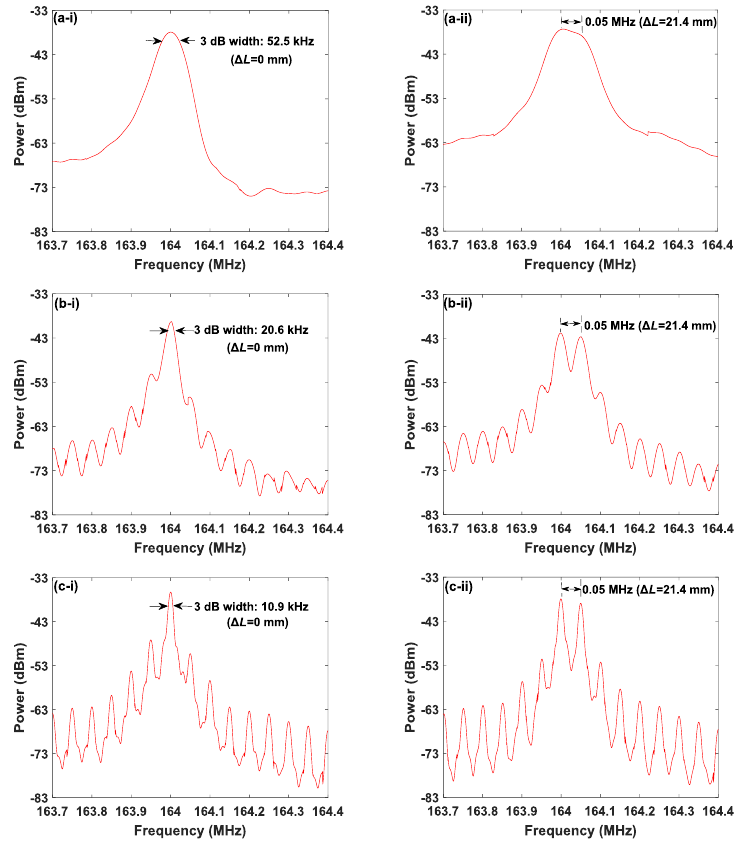
Figure 9. Power spectra of de-chirped signals under ( i ) 0 mm distance difference and ( ii ) approx- imately 21.4-mm distance difference for the RBW of ( a ) 50, ( b ) 20 and ( c ) 10 kHz. VBW: 1 kHz. Modulation period: 20 µ